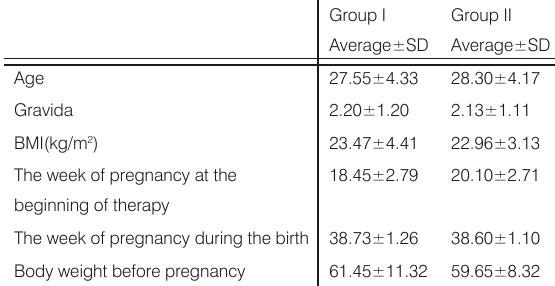
Table 1. Comparison of Criteria for Group I and Group II.